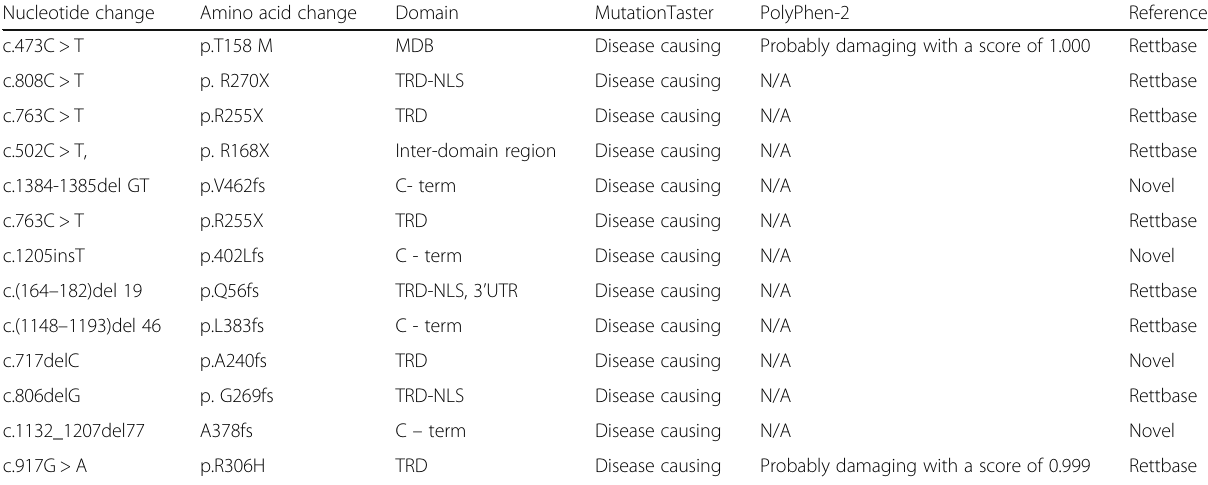
Table 3 In silico analysis to determine the causal relationship of the mutation and RETT syndrome Nucleotide change